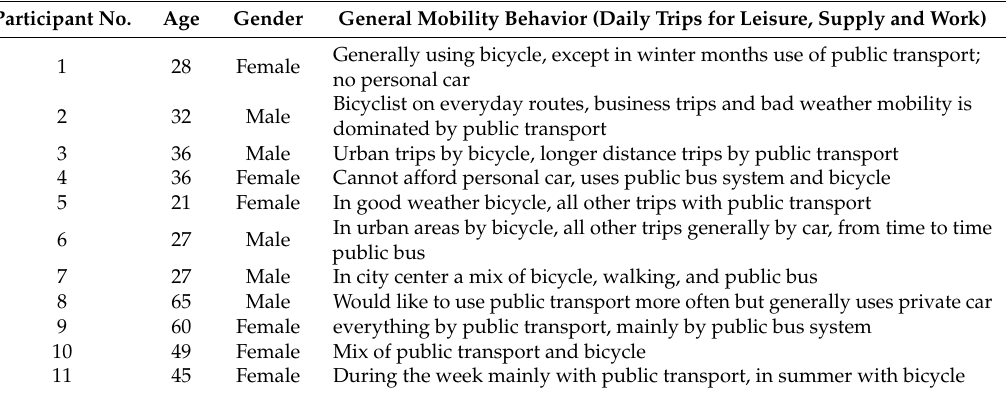
Table 1. Sample of focus group #1